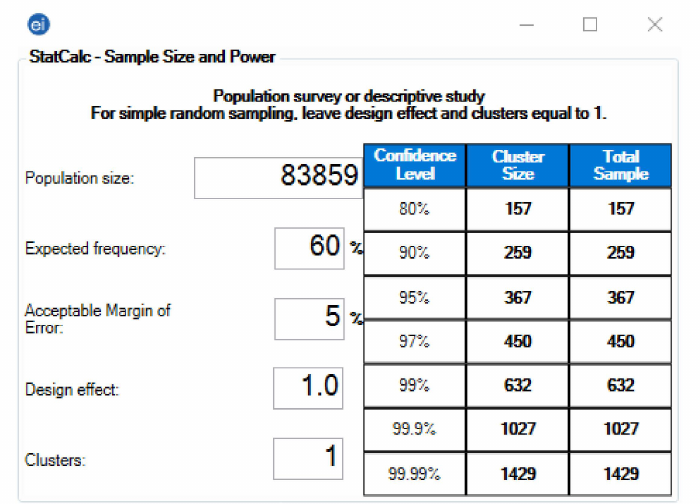
Figure 4. Sample size of the Slovak healthcare workers: Epi Info TM version 7.2.4. Population Size: According to the latest report of the National Health Information Centre (NHIC), there were 83,859 healthcare workers in Slovakia by 2019 [33]. Expected Frequency: The overall prevalence of side effects following COVID-19 vaccines ranged between 62% and 93% [19,67–69]. Acceptable Error Margin: 5% was assumed permissible because the expected frequency ranged between 10% and 90% [70]. Design Effect: 1–per the recommendation of the CDC for simple sampling [71]. Clusters: 1–per the recommendation of the CDC for simple sampling